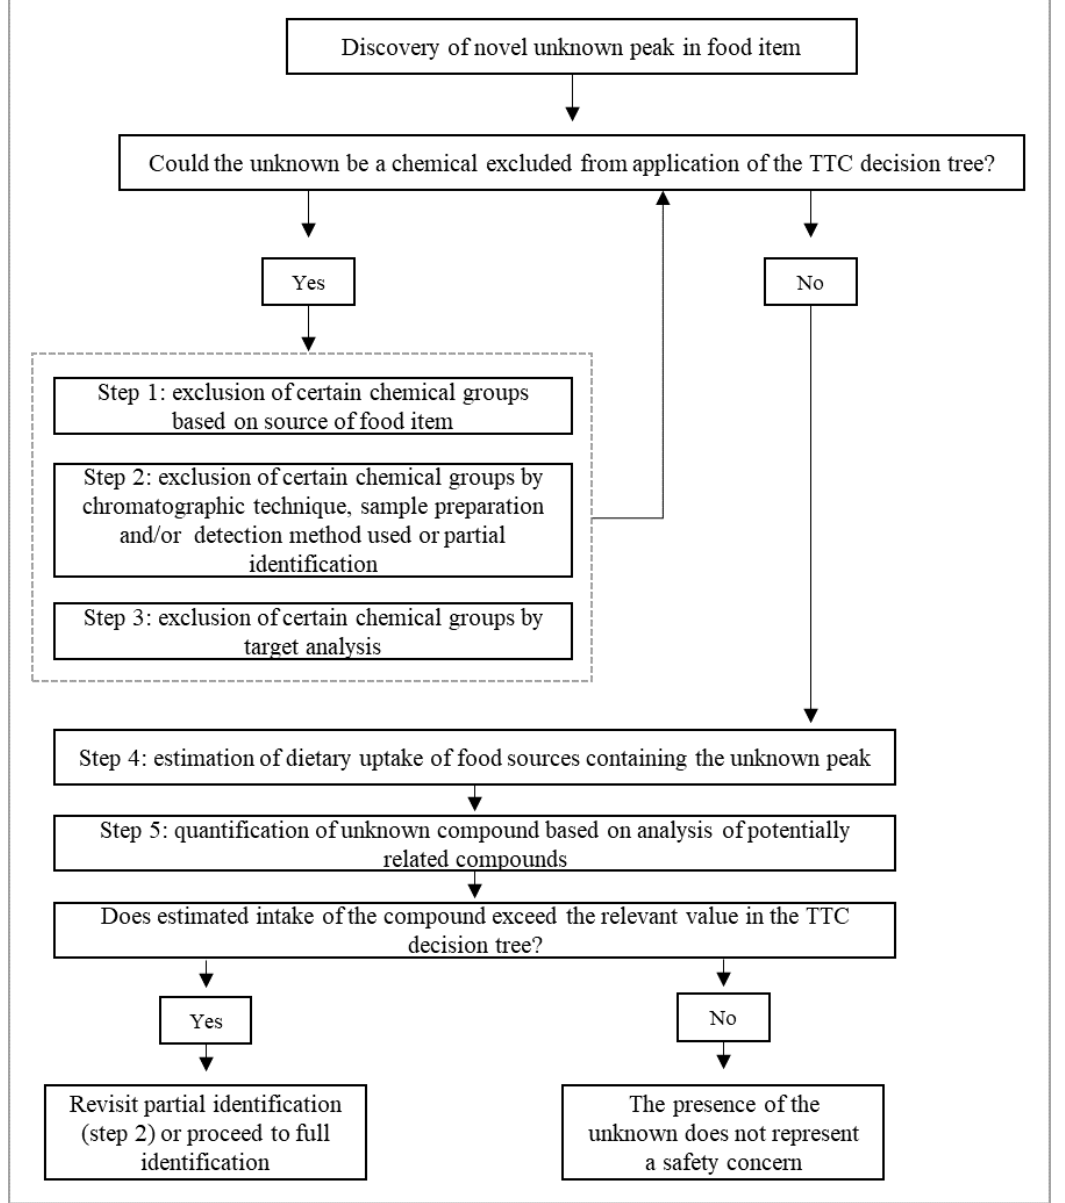
Figure 8. Overview of the approach to applying the Threshold of Toxicological Concern (TTC) concept to unknown peaks (adapted from Koster et al. [139]).